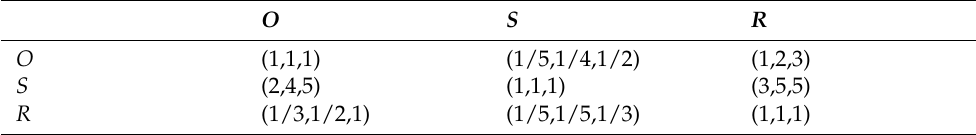
Table 8. Fuzzy pairwise comparison matrix for expert E 1 .